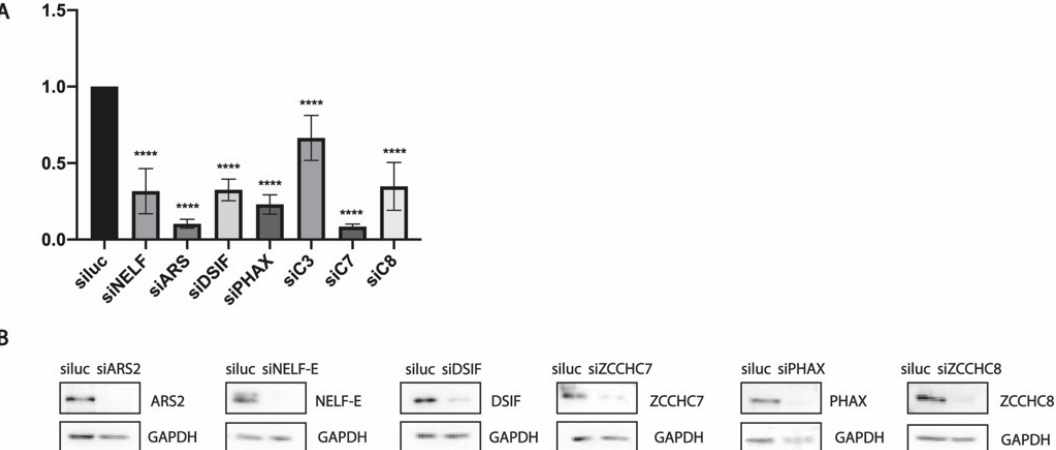
Figure A1. The quality of cellular extract separation was confirmed by RNA and protein analysis. ( A ) The RNA purified from the nuclear (NE) and cytoplasmic (CE) fractions of HEK293T cells was subjected to RT-qPCR to determine the amount of unspliced GAPDH (preGAPDH) and spliced GAPDH transcripts and U6 snRNA. ( B ) The total cellular protein (T) and proteins extracted from the CE and NE fractions were analyzed by Western blotting with the specified antibodies.